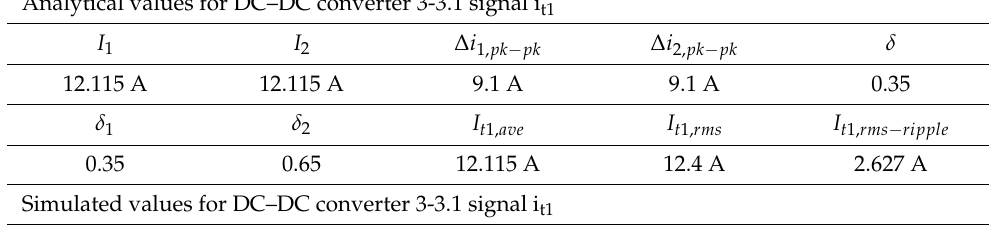
Table 4. Analytical and simulated data for converter 3-3.1 under CCM .